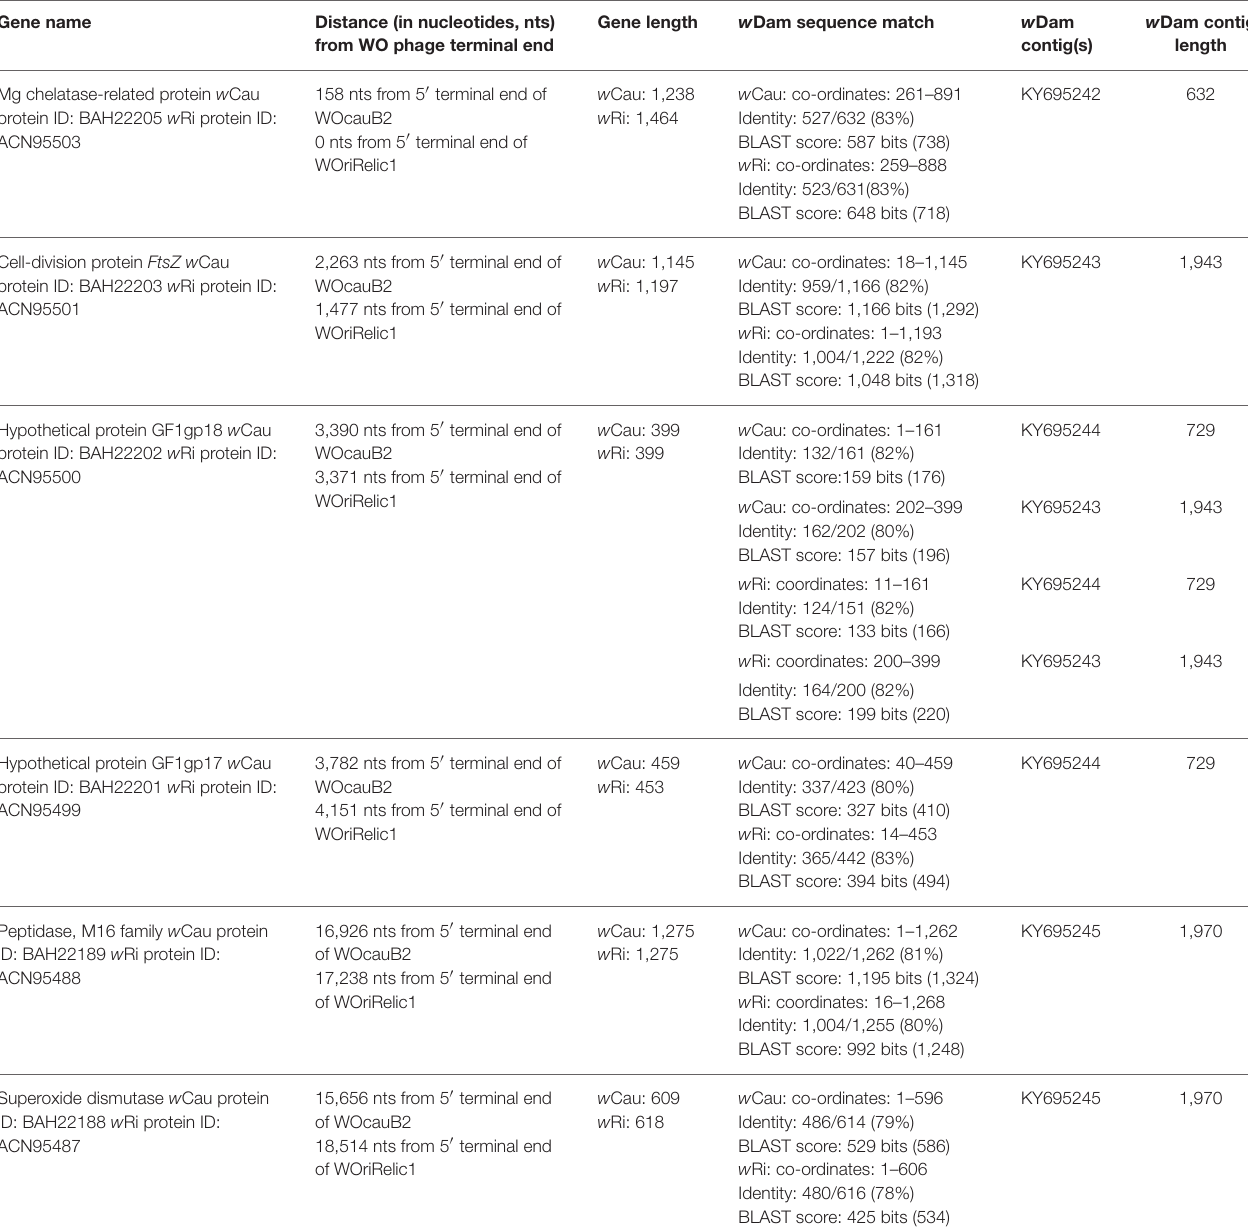
TABLE 1 | w Dam shot-gun sequence contigs from matching known and predicted serine recombinase WO upstream integration